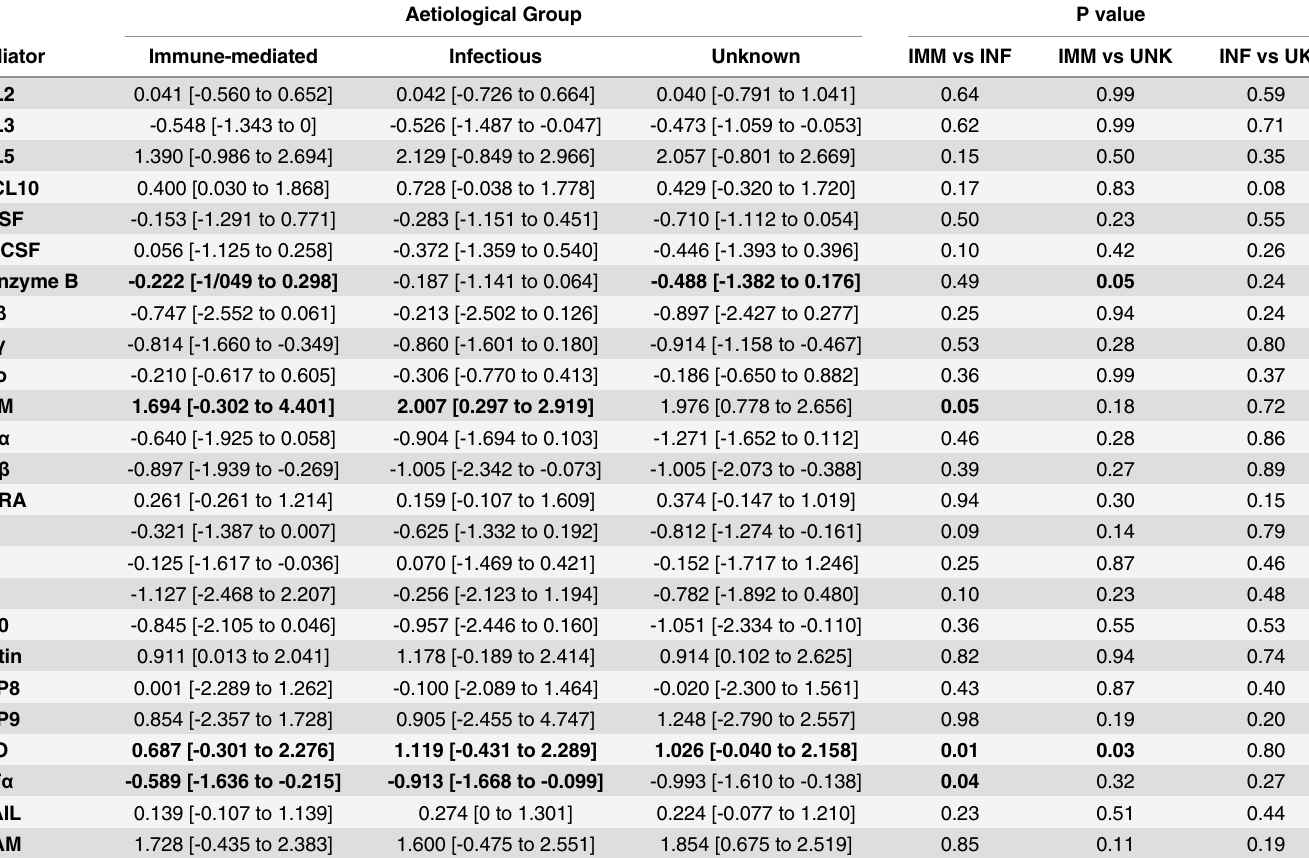
Table 3. Median concentrations of identified mediators between the aetiological groups of encephalitis in